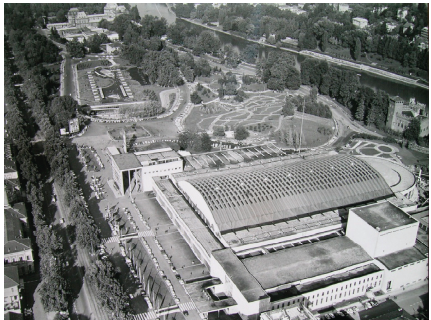
Figure 1: Aerial view of the Turin Exhibition Centre: the large hall with the semicircular apse is Hall B built in